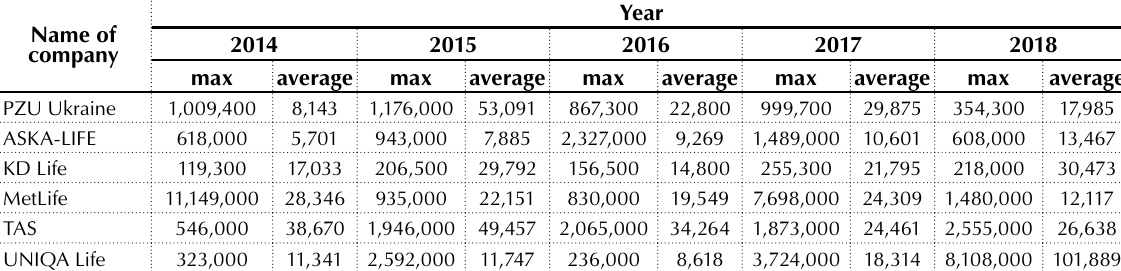
Table A2. Number of insured, persons Name of company